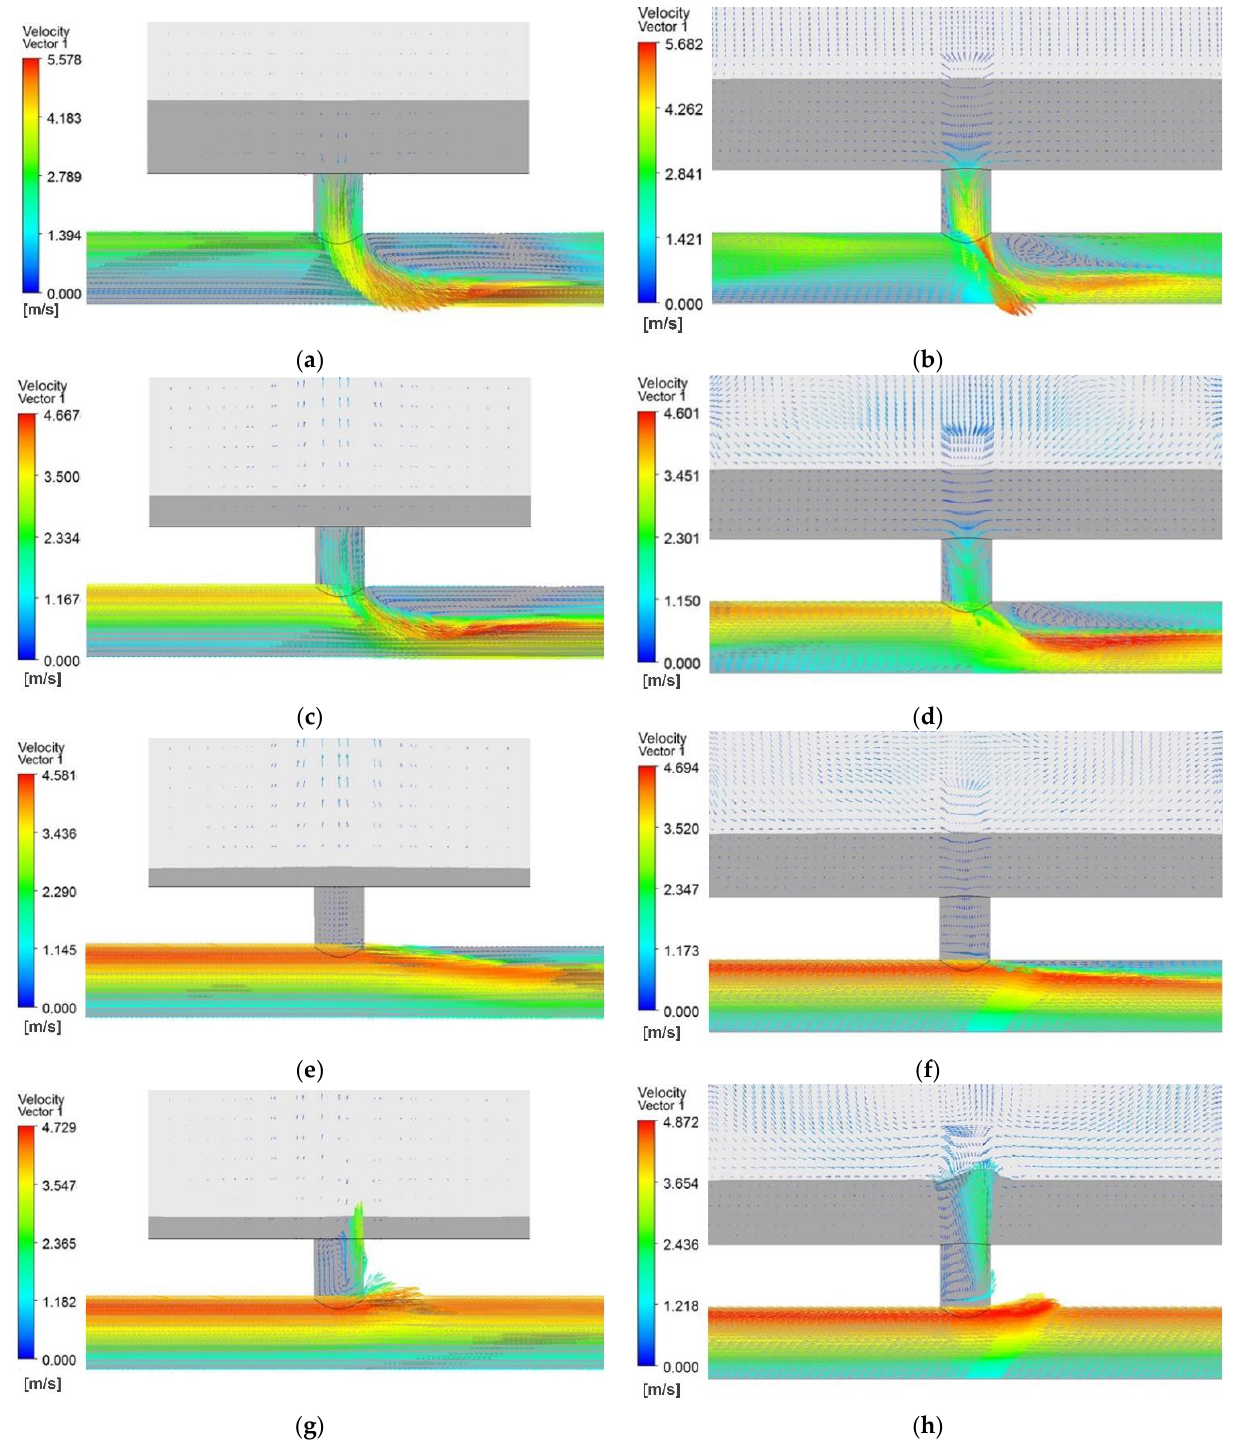
Figure 7. Comparison of horizontal and vertical ACSC flow regimes at different time points: ( a ) vertical ACSC at T = 23.5 s; ( b ) horizontal ACSC at T = 23.5 s; ( c ) vertical ACSC at T = 45 s; ( d ) horizontal ACSC at T = 45 s; ( e ) vertical ACSC at T = 67 s; ( f ) horizontal ACSC at T = 67 s; ( g ) vertical ACSC at T = 80 s; ( h ) horizontal ACSC at T = 80